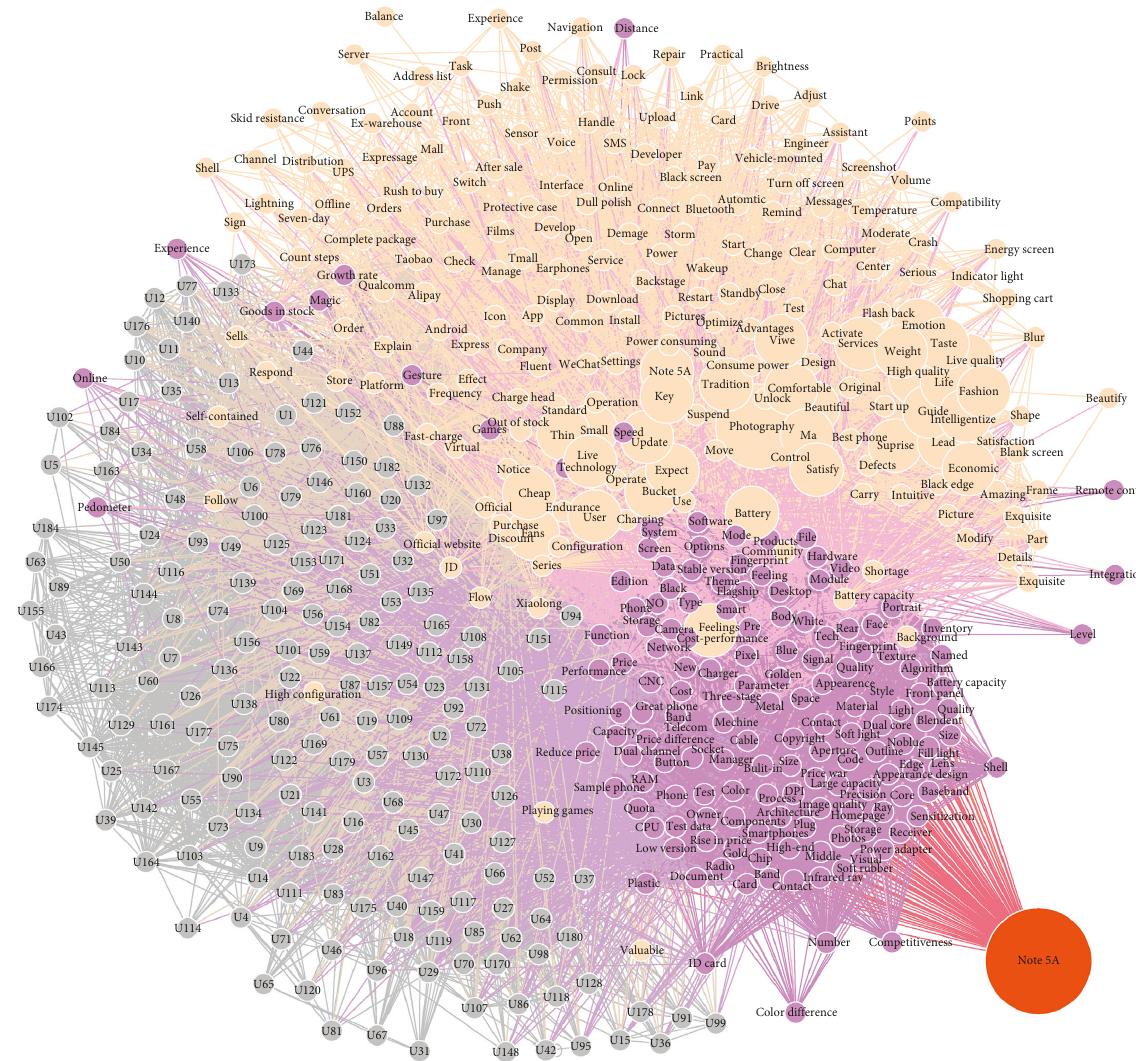
Figure 16: Visualized co-creation cyberspace model for product